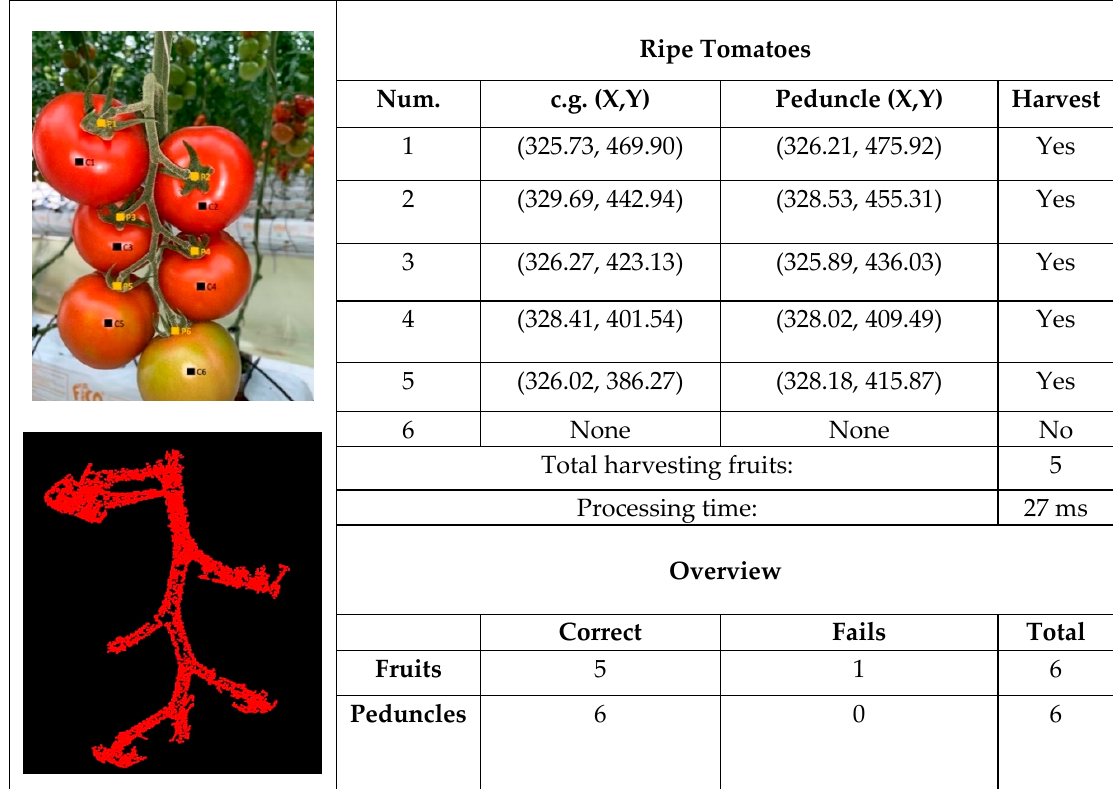
Figure 19. Beef tomatoes: centers, peduncle detection and results.